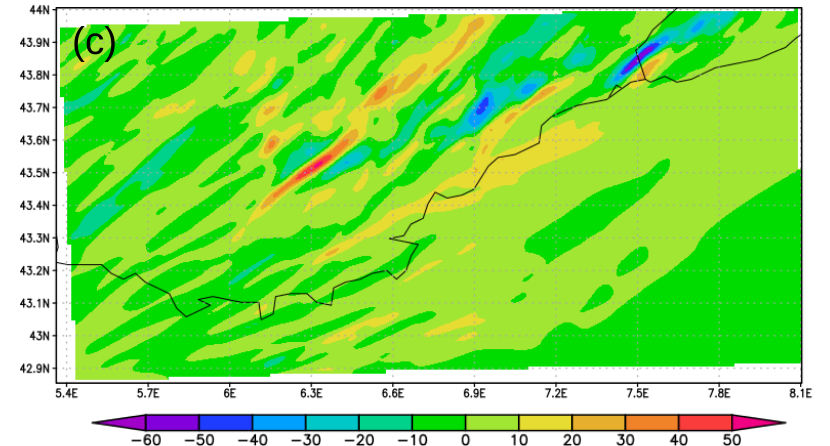
Figure 10. Panel ( a ): The 6 h simulated precipitation (mm) provided by W_ECM simulation. Panel ( b ): the 6 h simulated precipitation (mm) provided by W_ECM_SST. Panel ( c ): 6 h cumulated precipitation difference (mm) between W_ECM and W_ECM_SST simulations. Accumulation period is 17 UTC–23 UTC, 3 October 2015. Black star identifies observed precipitation peak